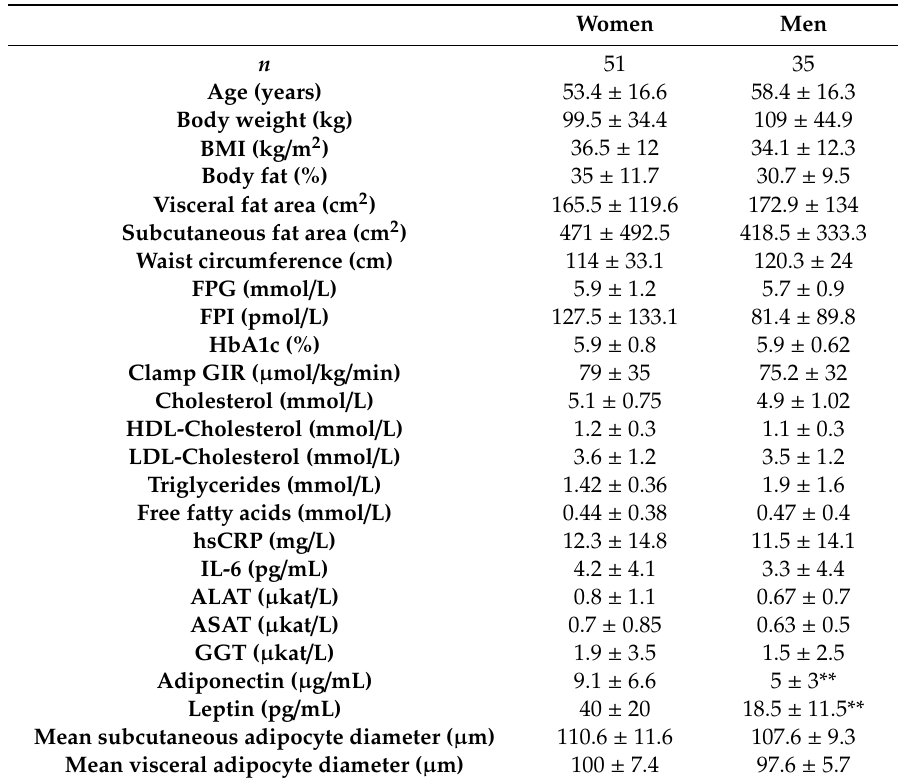
Table 1. Characteristics of the study